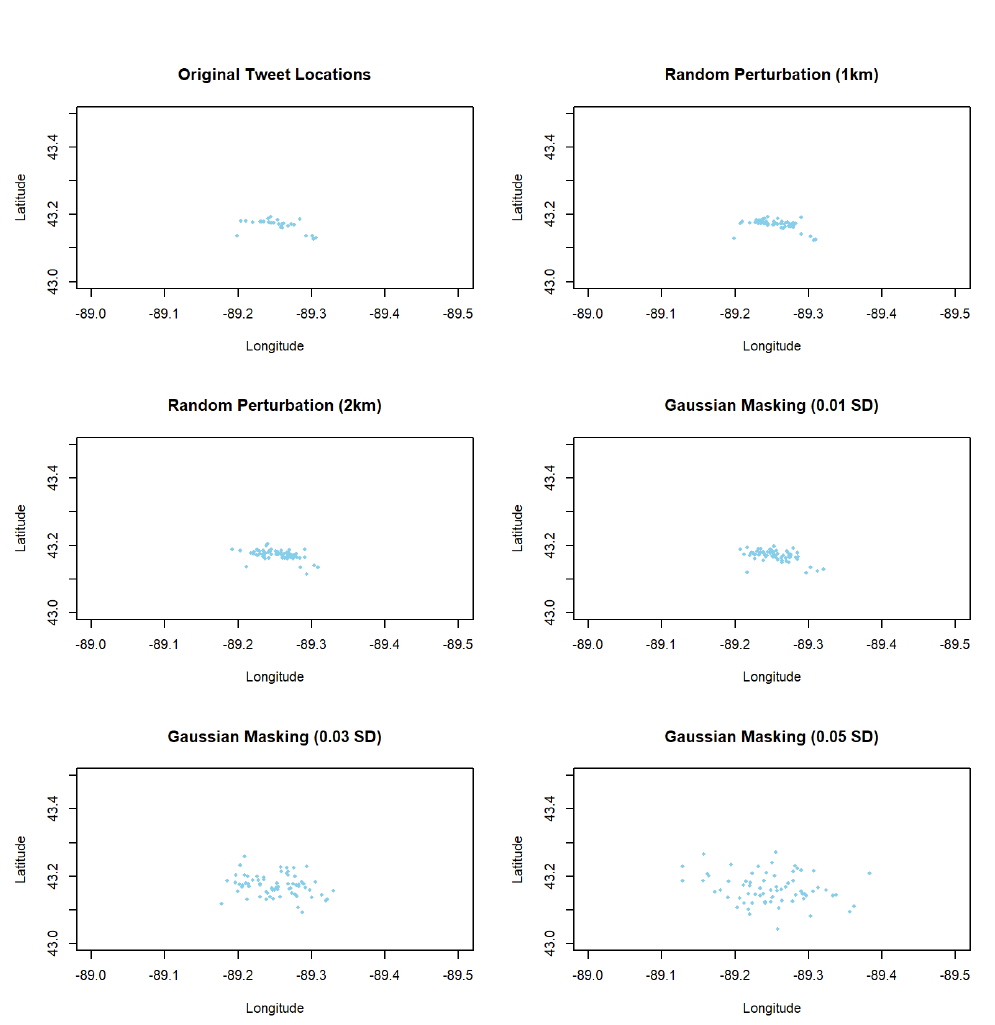
Figure 2: The Gaussian geomasking with different standard deviations (SD) and the ran- dom perturbation with 1km and 2km threshold of a user’s geotagged tweets.